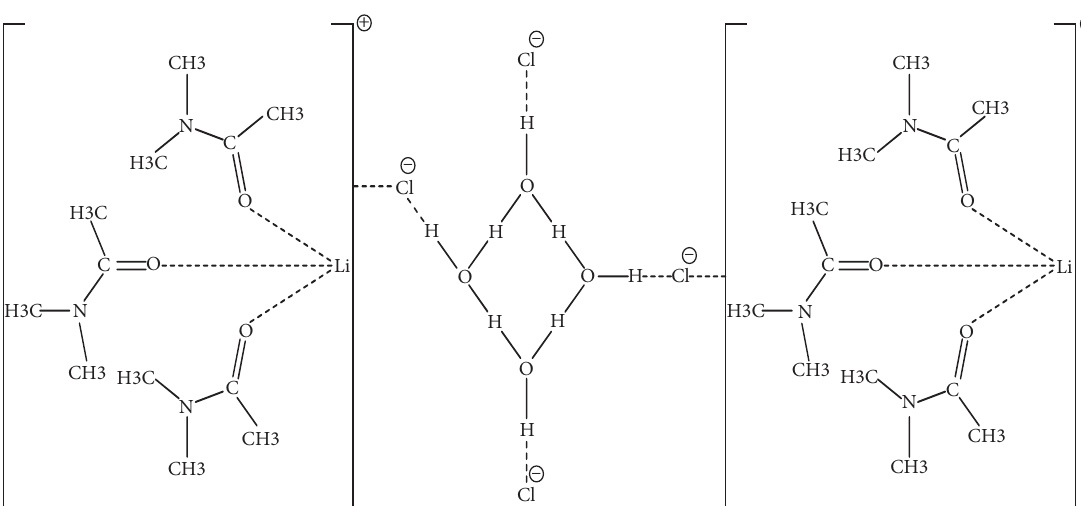
Figure 7: The formation of the macrocation [DMAc-LiCl-DMAc-Li] + and the hydration between Cl − ion and water molecules. Table 1: Characteristics of the chitin hydrogel prepared at various LiCl contents.